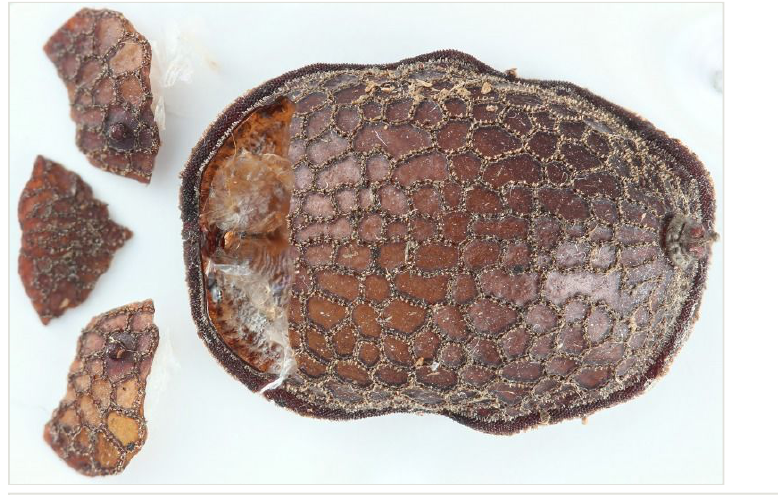
A microdontine puparium, dorsal view (individual No. 2). Pieces of the puparium (left) formed after eclosion.